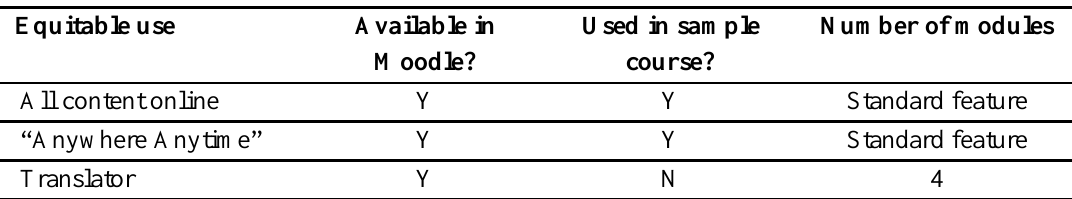
Availability of Moodle Modules Serving the Equitable Use Principle Equitable